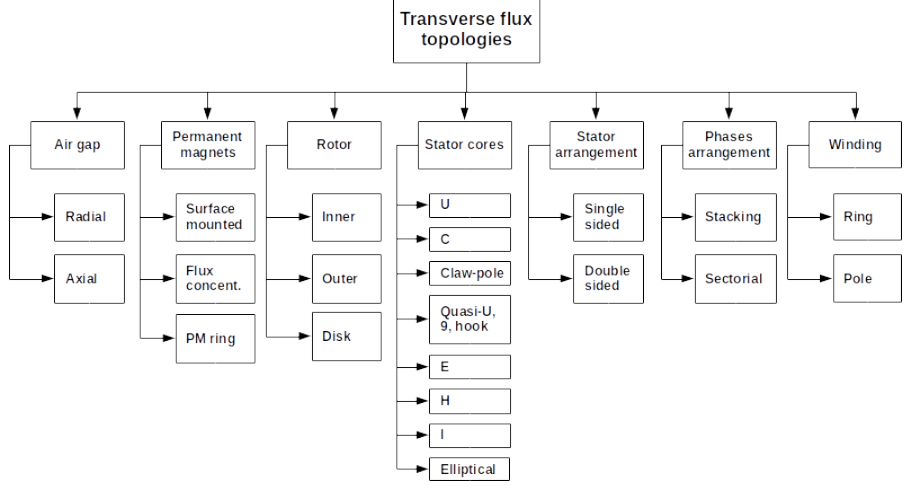
Figure 4. Transverse flux